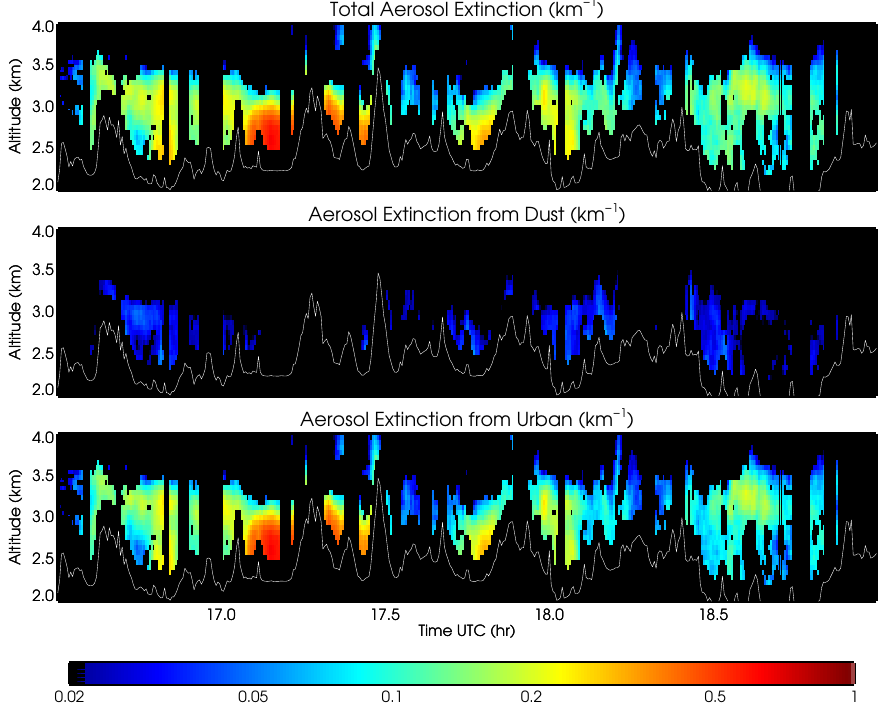
Fig. 5. Partition of extinction into contributions by the two pure types, dust and urban, for the HSRL-1 measurements on 15 March 2006. The top panel shows the total aerosol extinction; the middle panel shows the aerosol extinction attributed to dust; the lower panel shows the aerosol extinction attributed to urban